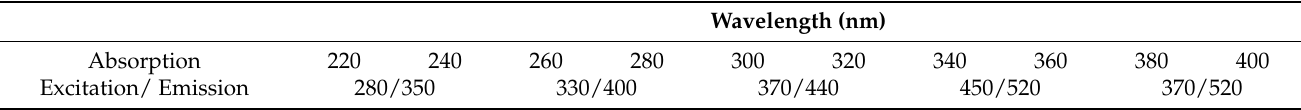
Table 2. Wavelength settings of absorption and fluorescence detectors.